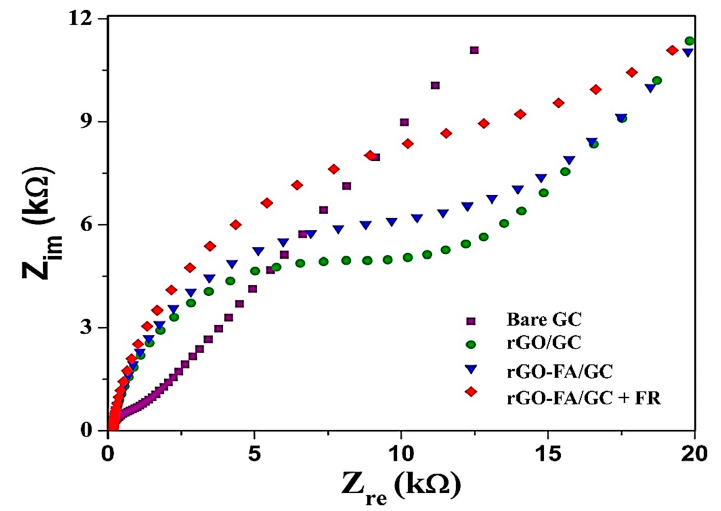
Figure 7. EIS spectra of bare GC, rGO/GC, rGO-FA/GC, and rGO-FA/GC + 10 nM FR in 0.1 M [Fe(CN) 6 ] 3 − /4 − at a frequency range of 10 Hz − 100 kHz.